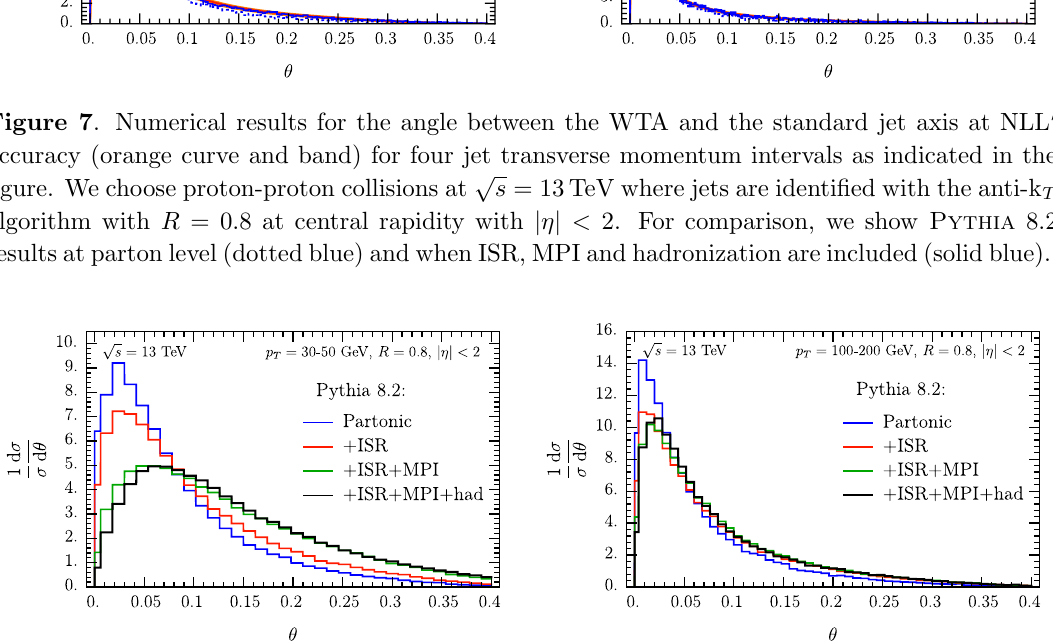
Figure 8 . Pythia results for the angle between the standard and WTA jet axis, for the kinematics corresponding to the upper row in (cid:12)gure 7. Shown are the partonic result (blue), including ISR (red), MPI (green) and also hadronization